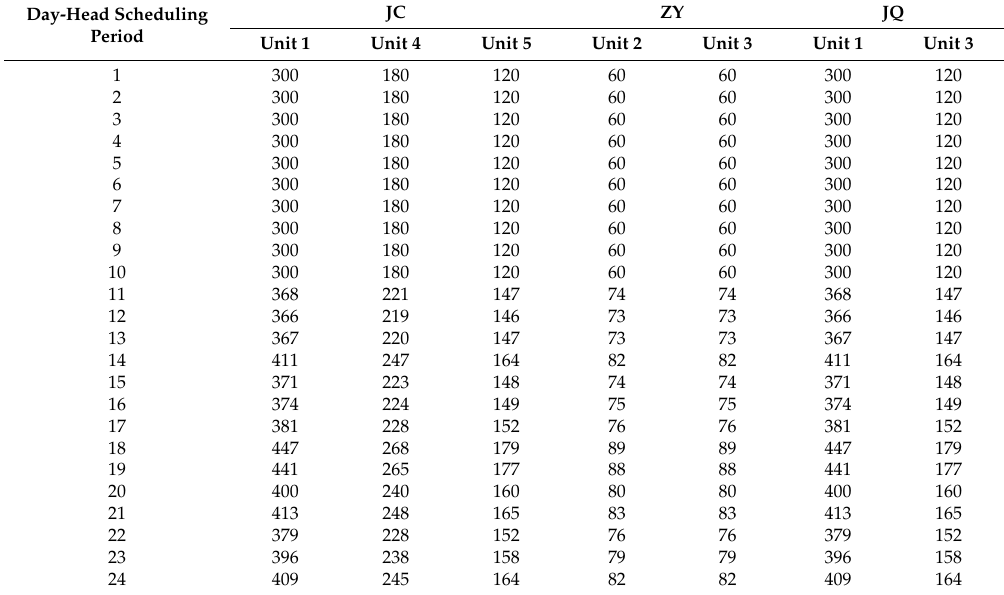
Table 7. Optimized day-ahead thermal generation schedules / (MW).